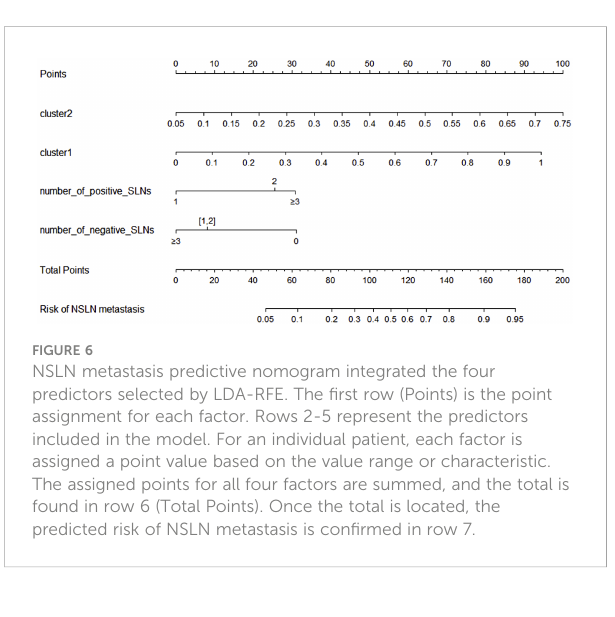
TABLE 2.1 Predictive performance of different NSLN metastasis predictive models in external validation, among NSLN metastasis predictive models using different numbers of SNPs.